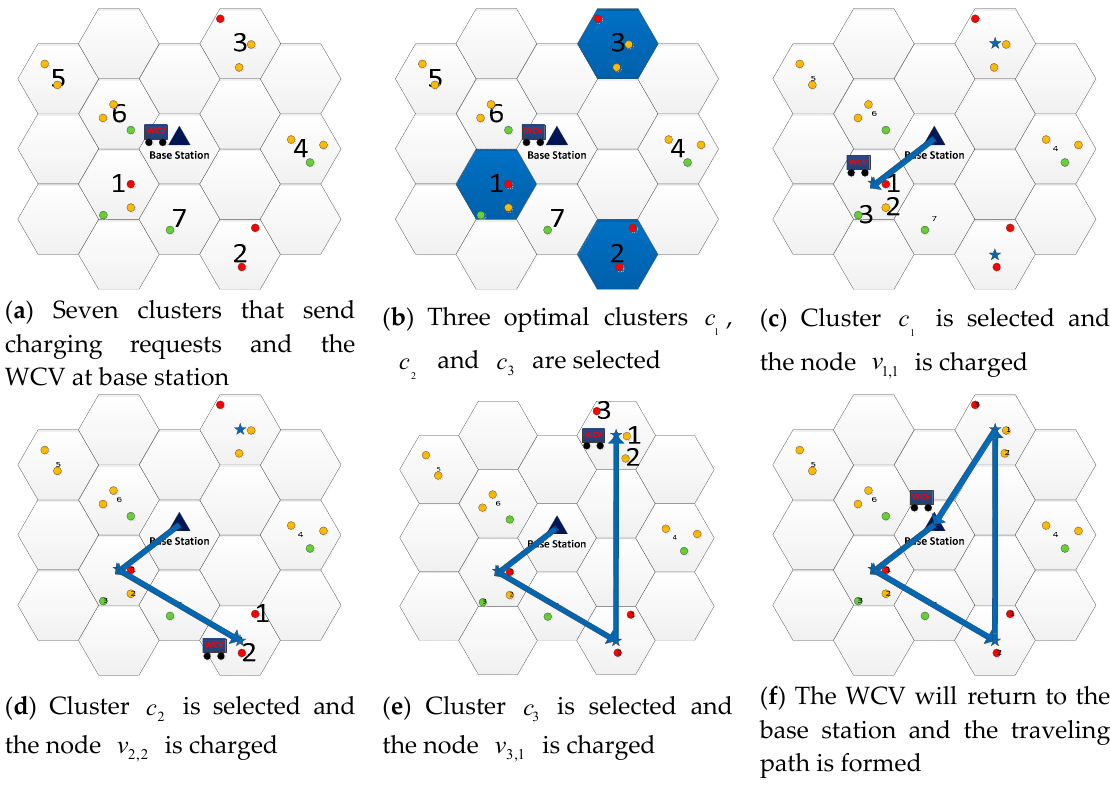
Figure 4. An example of the execution of Algorithm 2.